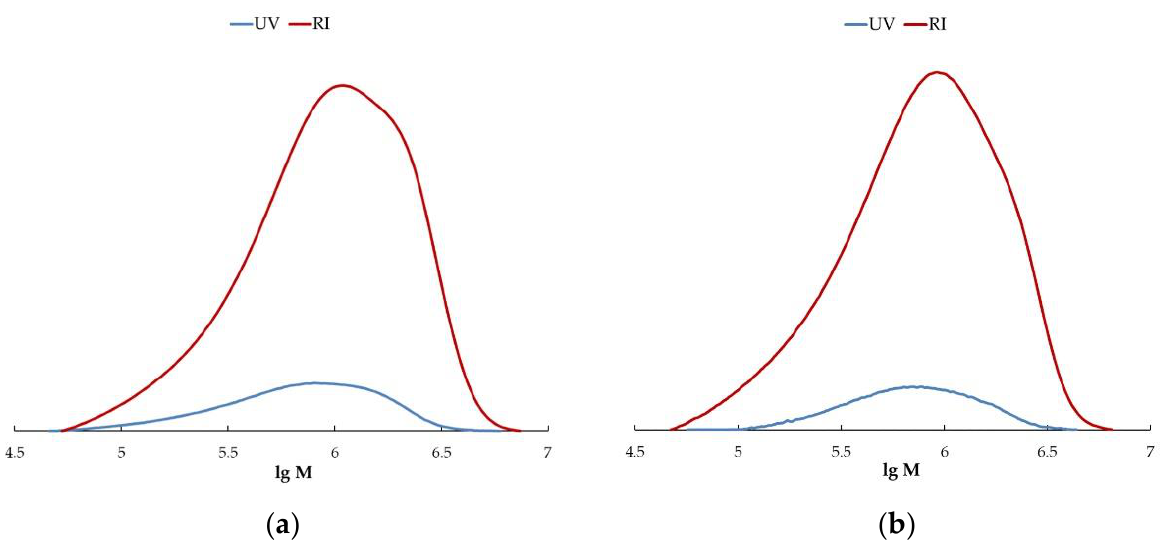
Figure 7. MWD curves taken on UV- and refractometric detector of PMMA isolated by enzymatic hydrolysis from Gel-PMMA copolymers synthesized in the presence of ( a ) AIBN, TBB, and 2,5-DTBQ; ( b ) TBB and 2,5-DTBQ.